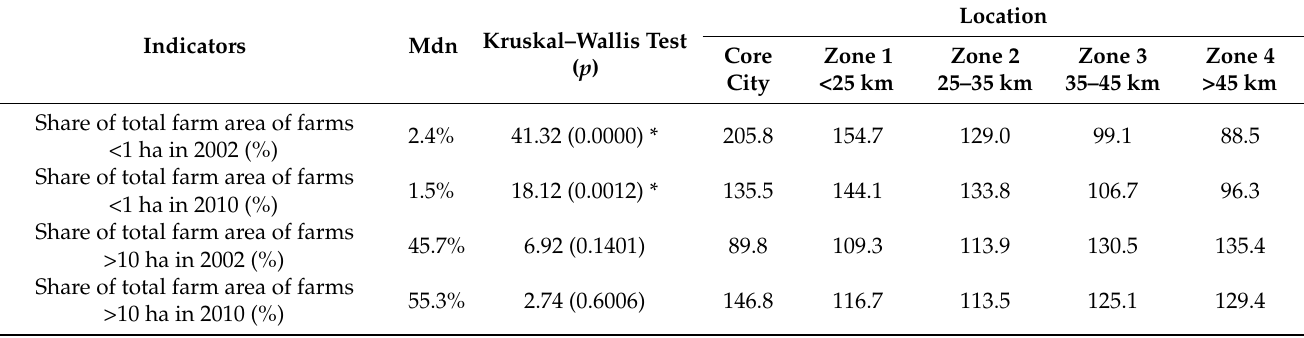
Table 7. Median and medium rank size of selected variables building factor F3, depending on the location.